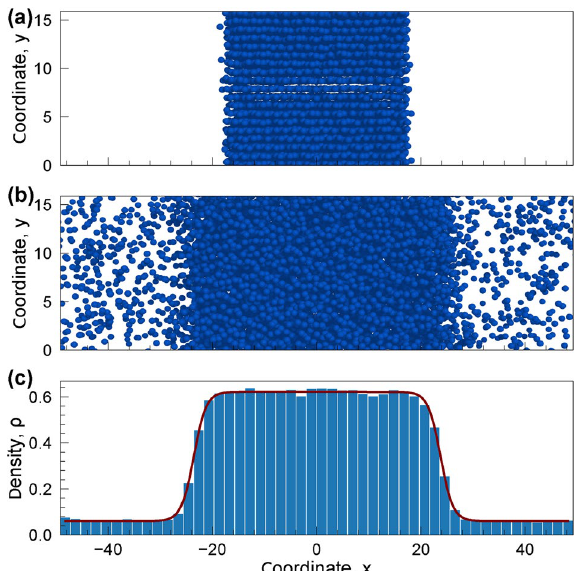
Figure 5. Flat layer of LJ12-6 particles: Snapshot of the system in initial state ( a ) and at T = 1.13 ( b ). ( c ) Density profile of the system along the x -axis. The high- and low-density regions are in the liquid and gas state, respectively. The dark red line is the approximation of the density profile by Eq.